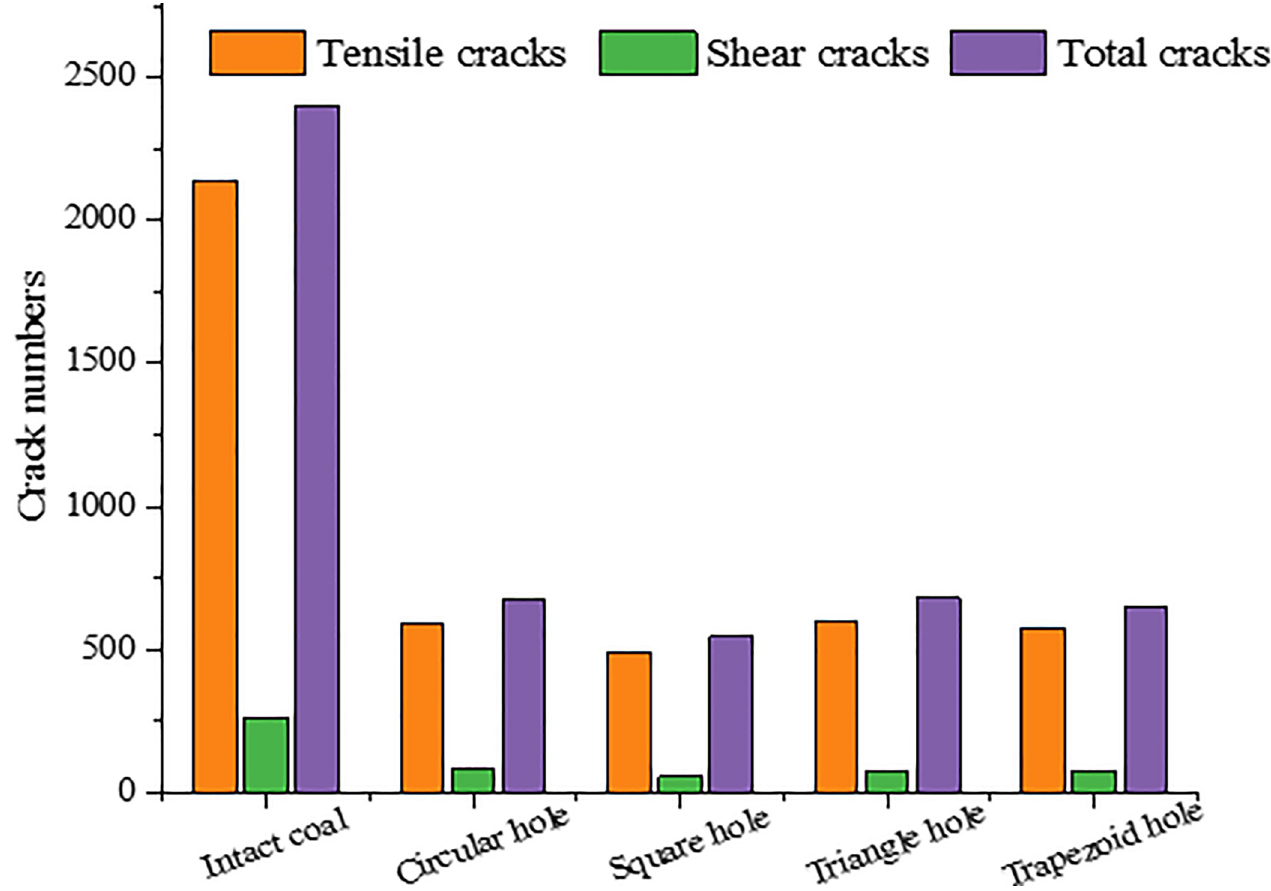
Fig 10. Number of micro-cracks in coal and rocks with hole defects of different shapes.